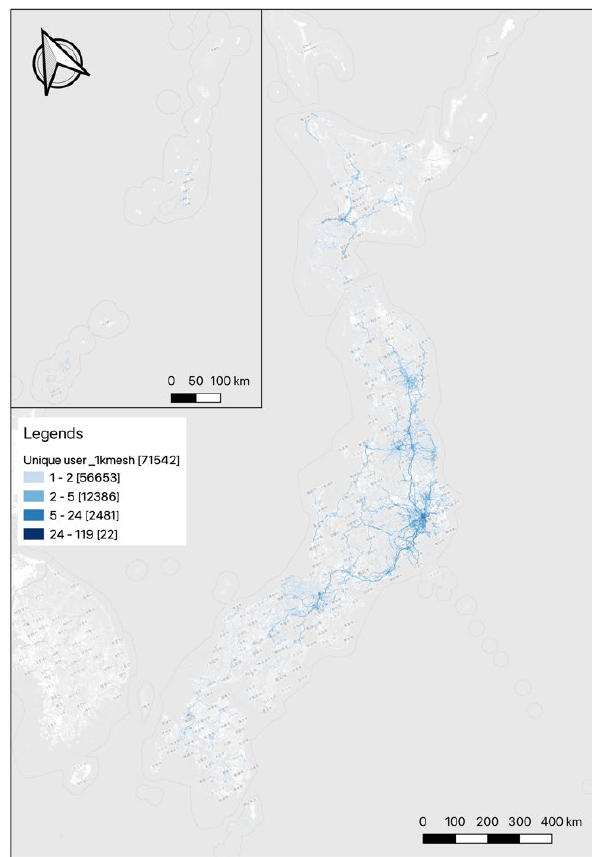
Figure 3. Number of unique Mapillary users per 1-km mesh.